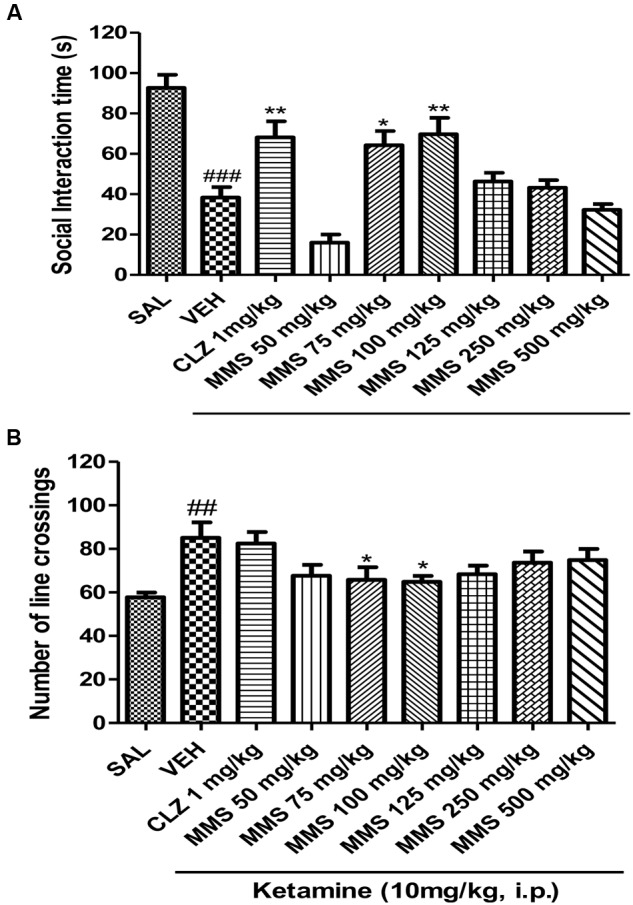
Effect of MMS (50–500 mg/kg, p.o.) or clozapine (CLZ; 1 mg/kg, p.o.) on ketamine-induced (A) social interaction time and (B) number of line crossings. Statistical significance: ###p < 0.001, ##p < 0.01 compared with the saline control group; ∗∗p < 0.01, ∗p < 0.05 compared with the vehicle control (VEH) group.